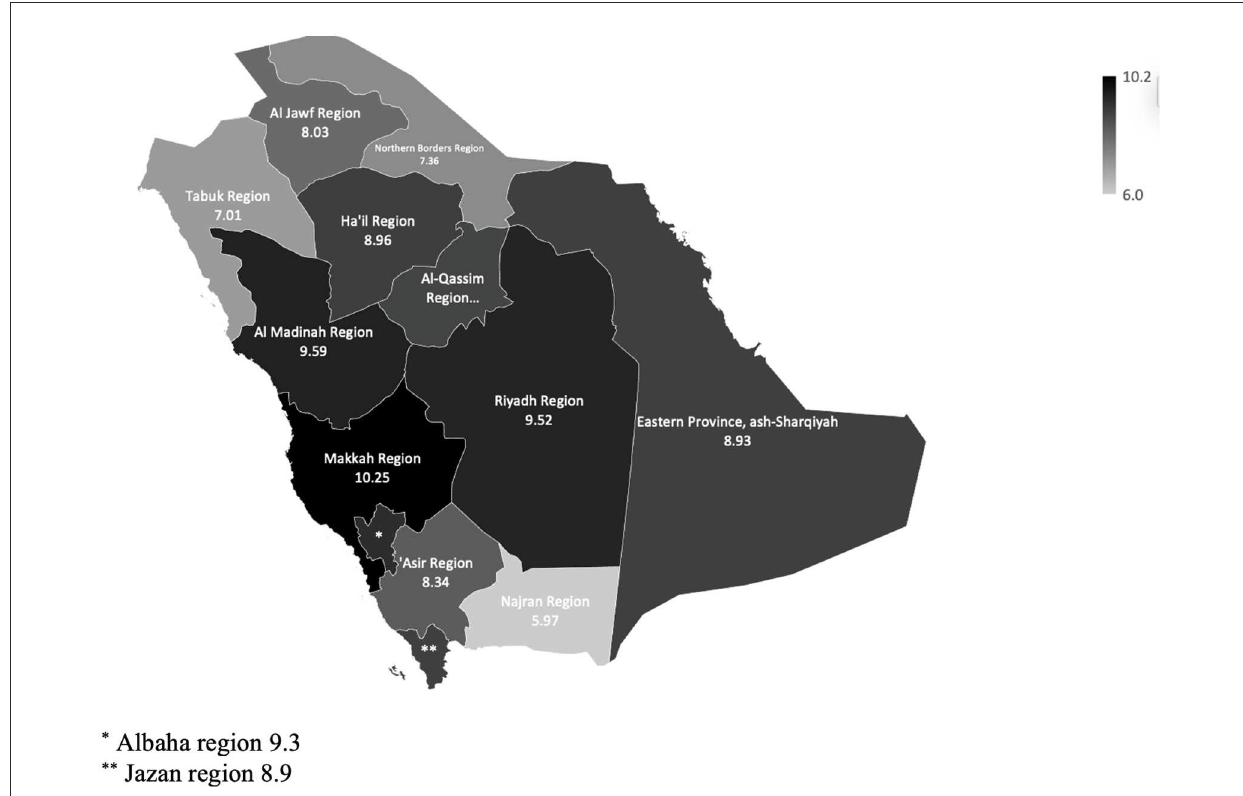
FIGURE3 The national and regional prevalence rates of